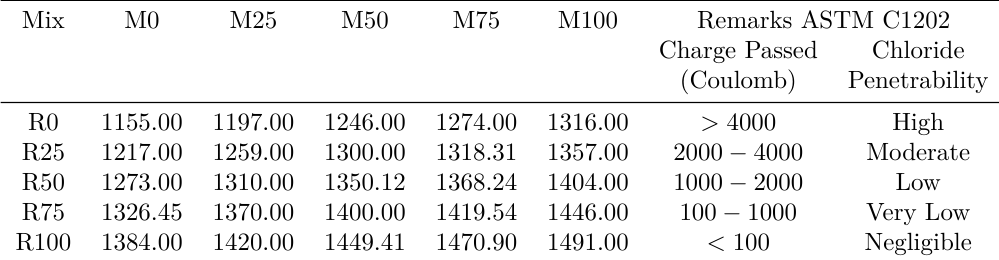
Table 4. Estimated RCPT value of SCC mixtures after 56